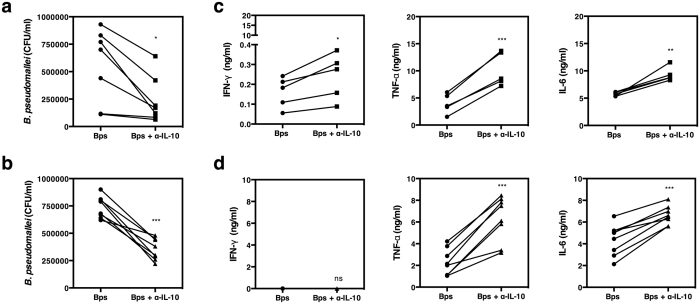
Neutralization of IL-10 increases the killing of B. pseudomallei by healthy individuals and individuals with DM.PBMCs from healthy individuals (n = 7) (a) and individuals with DM (n = 8) (b) were incubated with medium, live B. pseudomallei at an MOI of 1 in the presence or absence of 3 ug/ml of anti-IL-10 mAb for 6 hours. The number of live B. pseudomallei was assessed by colony forming unit assay. The cultured supernatants of healthy individuals (n = 5) (c) and individuals with DM (n = 8) (d) were assayed for IFN-γ, TNF-α and IL-6 by ELISA. Each symbol represents data from an individual. The values from the same individual in the presence or absence of anti-IL-10 mAb are joined by a line. Statistical significance was determined using paired T test; ns, non significant, *p < 0.05, **p < 0.01 and ***p < 0.001. Of note, cultured supernatants from 5 (c) out of 7 (a) healthy individuals were sufficient to be analyzed for cytokine response.